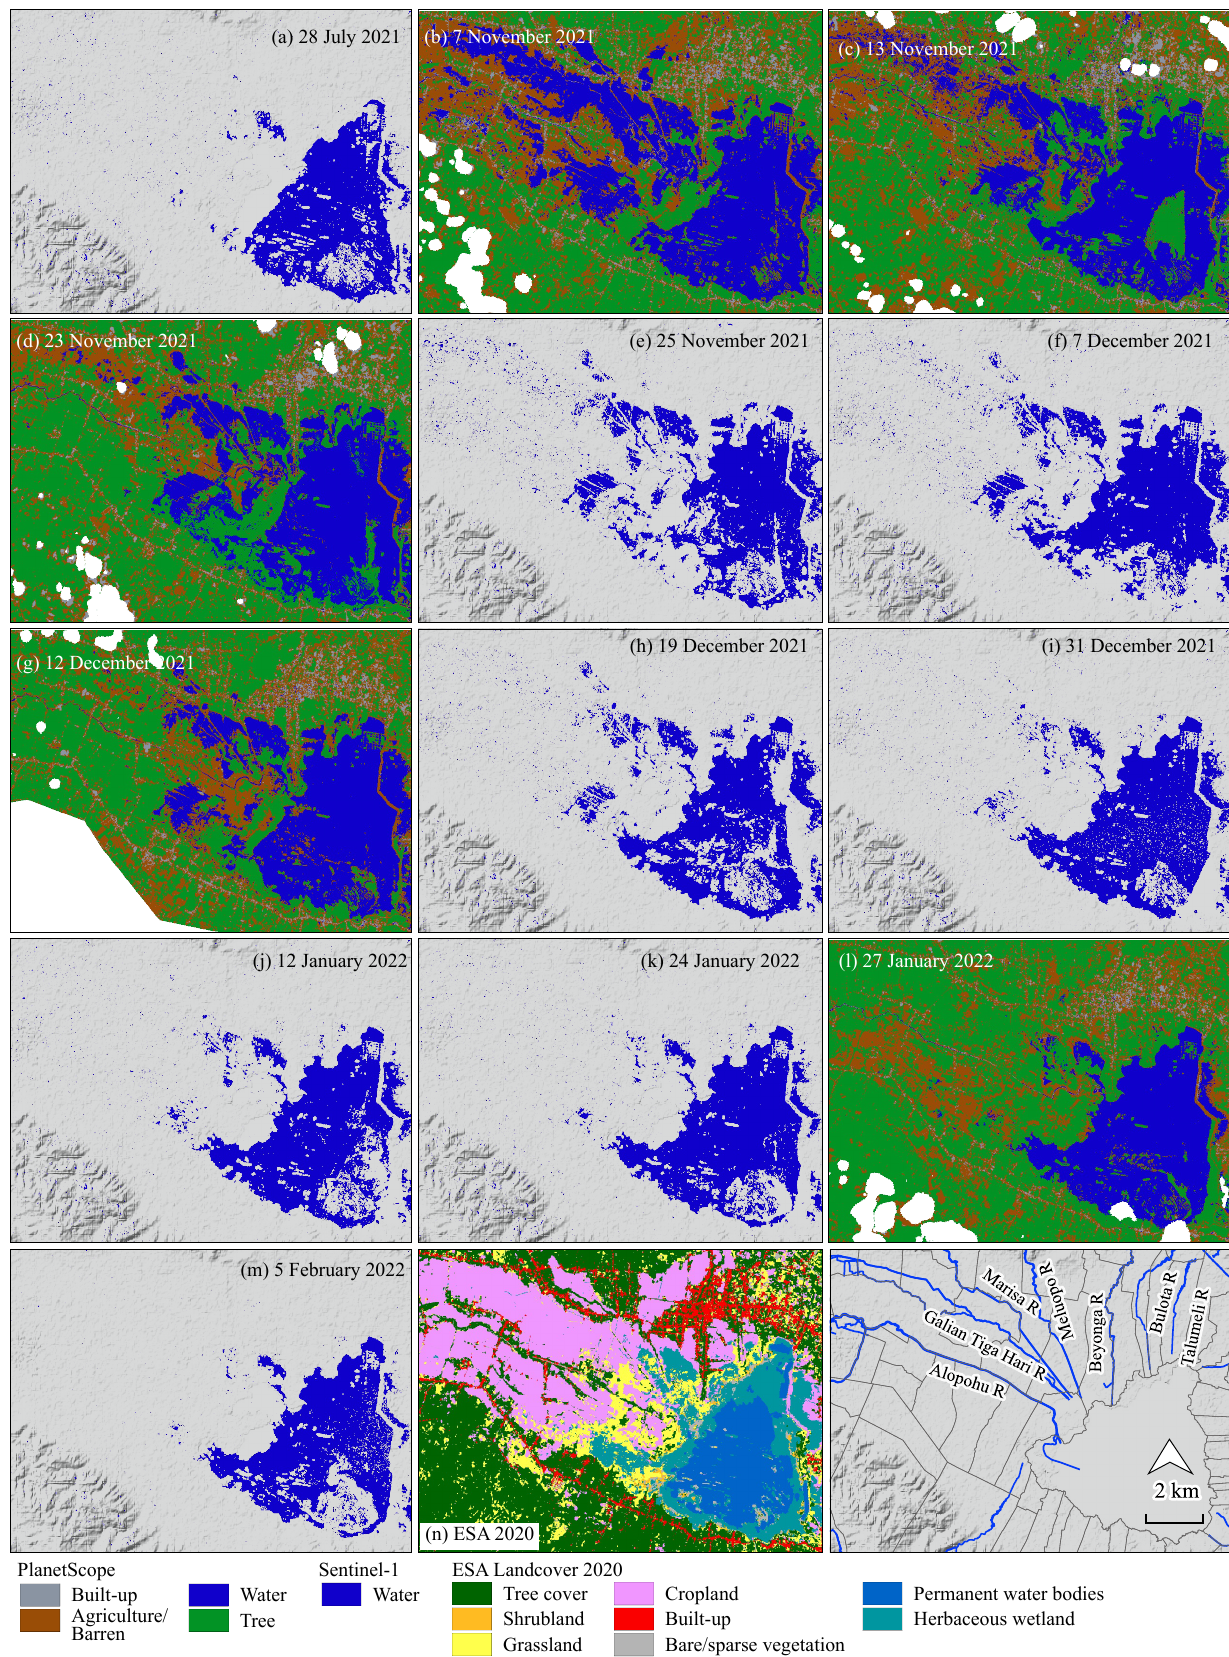
Figure 6. Landcover transformations and water areas using PlanetScope’s SuperDove and